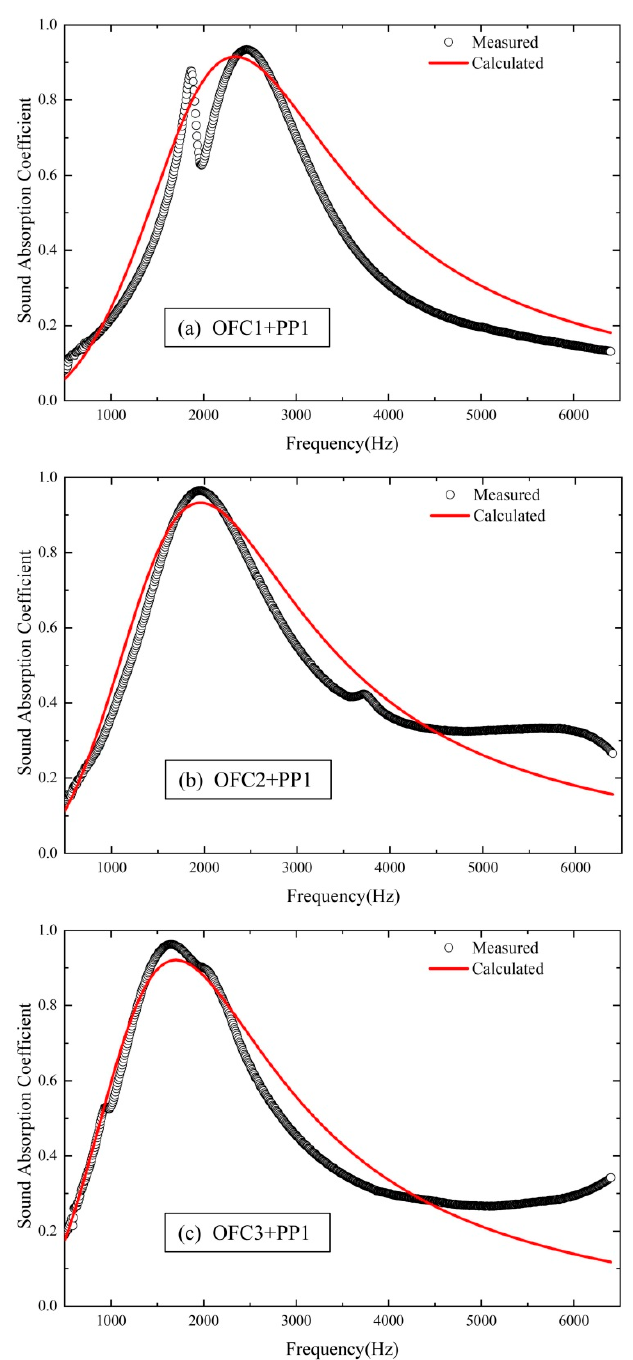
Figure 7. Comparison of the calculated and measured sound absorption coefficients: ( a ) composite structure composed of OFC1 and PP1; ( b ) composite structure composed of OFC2 and PP1; ( c ) composite structure composed of OFC3 and PP1.